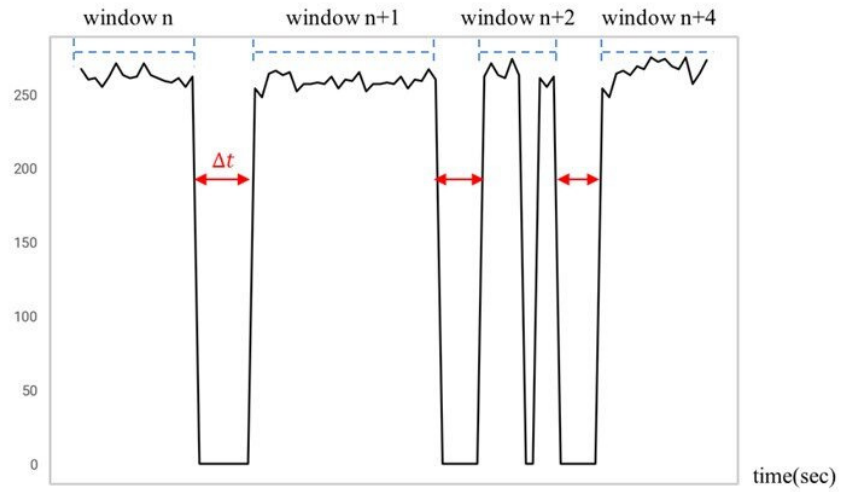
Figure 14. Session windowing for the weld time-series